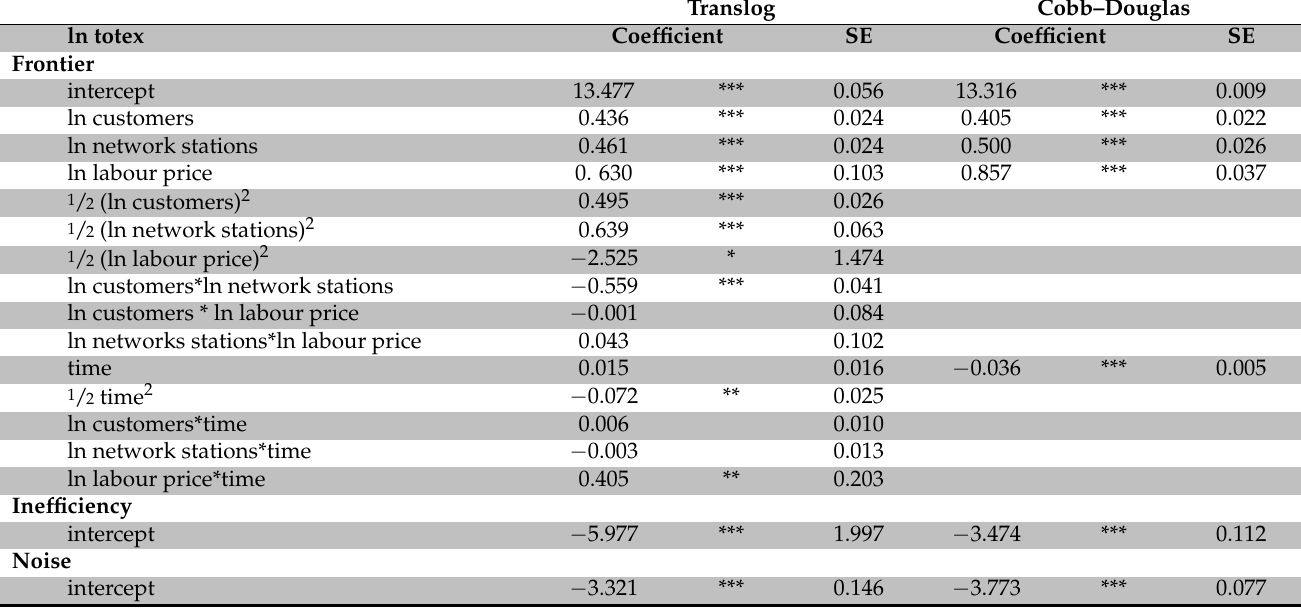
Table 2. Parameter estimates. Translog and Cobb–Douglas without inefficiency determinants.